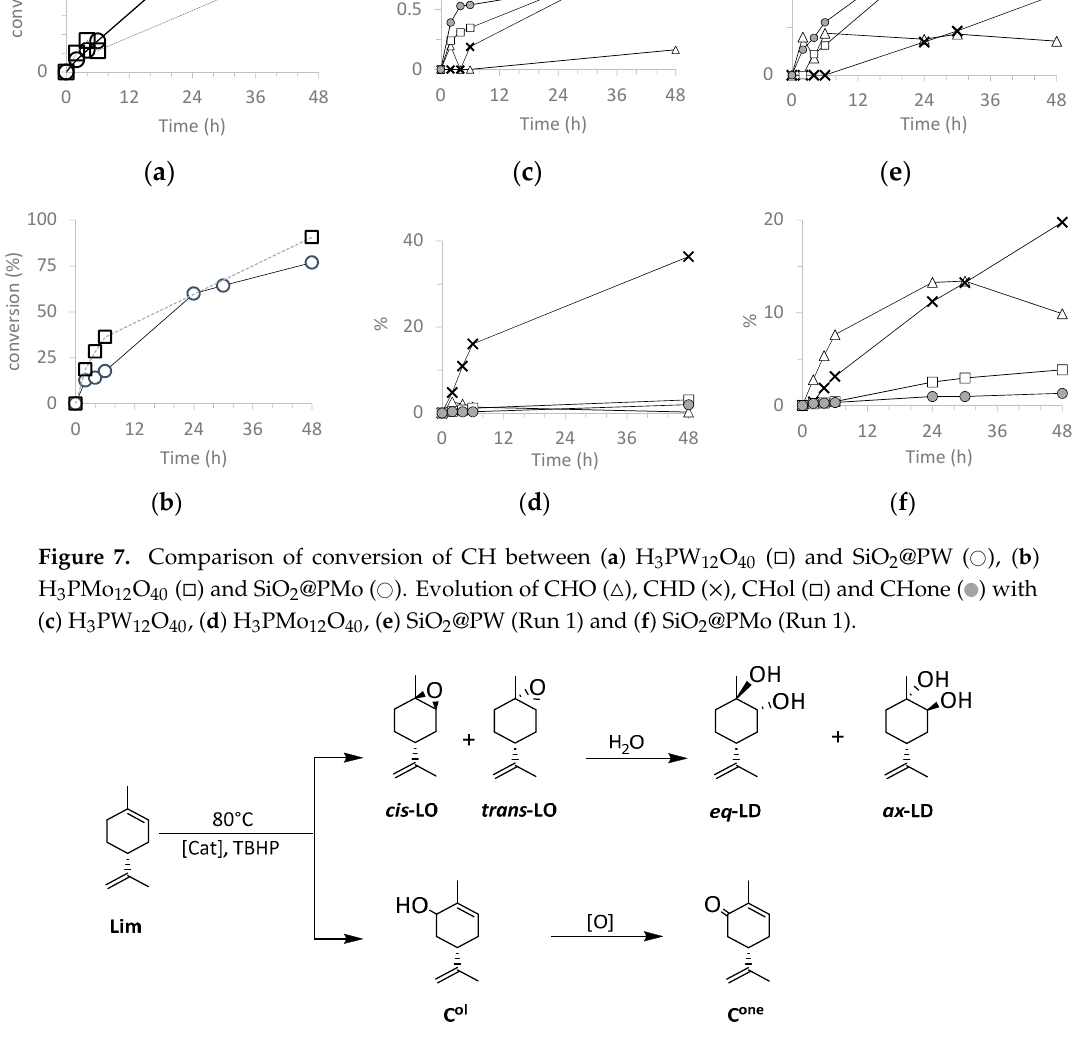
Table 5. Relevant data for the catalyzed oxidation of limonene 1